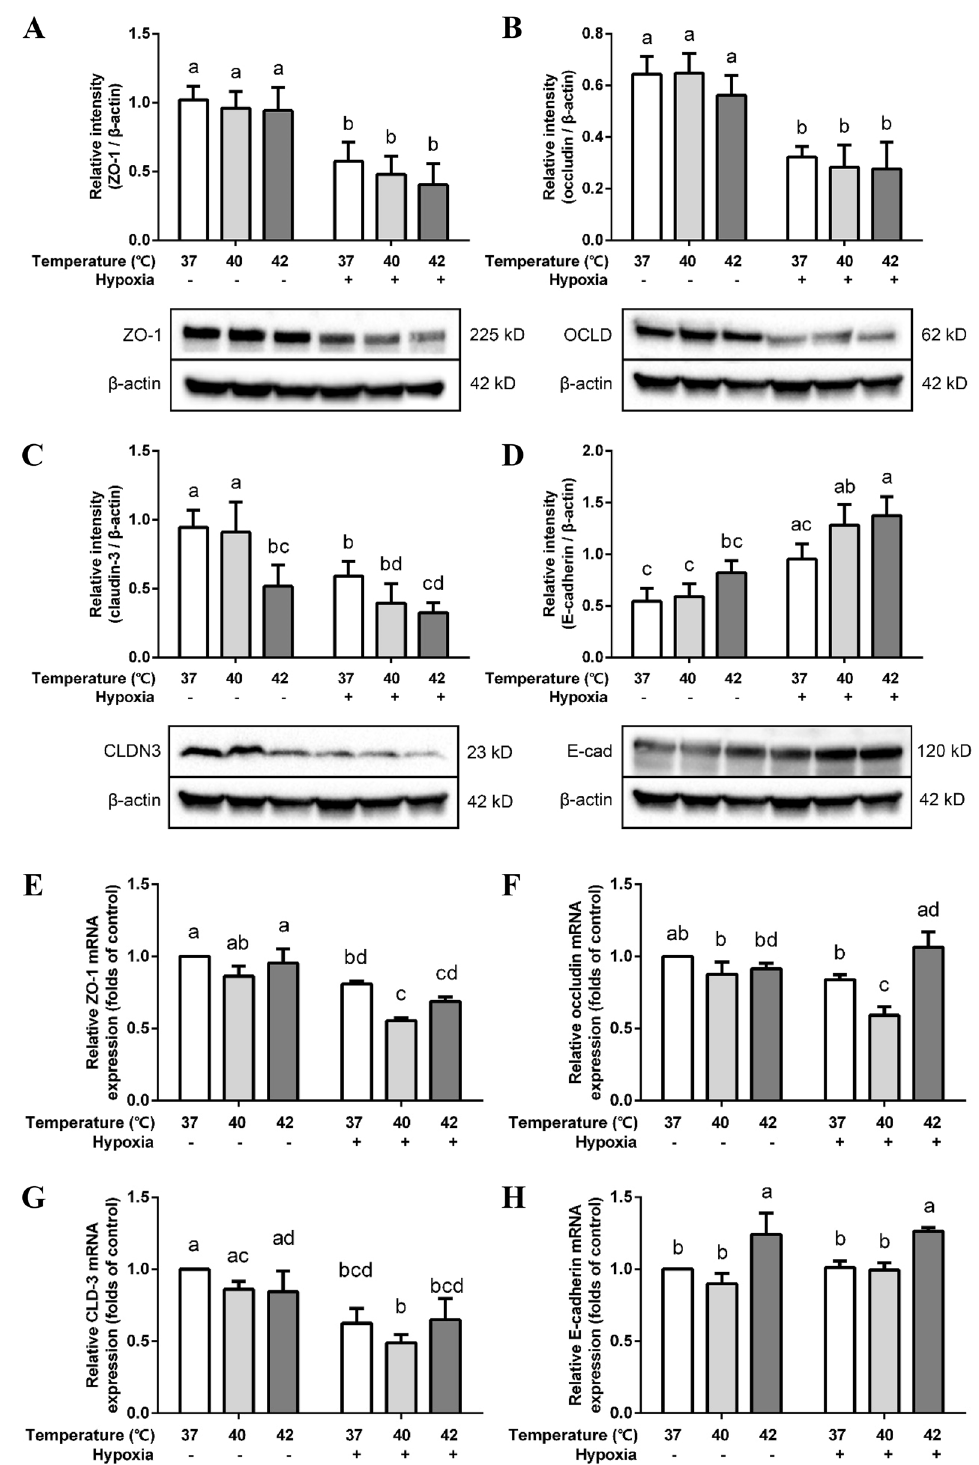
Figure 4. Effects of hypoxia and/or heat treatment on TJ/AJ proteins in the co-culture model. Relative protein expression of ZO-1 ( A ), occludin ( B ), claudin-3 ( C ) and E-cadherin ( D ) assessed by Western Blot. All target proteins were normalized to reference protein β-actin. ZO-1 ( E ), occludin ( F ), claudin-3 ( G ) and E-cadherin ( H ) mRNA levels were assessed by qRT-PCR. The target genes were normalized to housekeeping gene β-actin. All values were presented as means ± SD (N = 3, n = 3). Statistical differences were analyzed by two-way ANOVA followed by the Bonferroni’s multiple comparison test. Means without a common letter differ at p < 0.05. OCLD occludin; CLDN3 claudin-3; E-cad